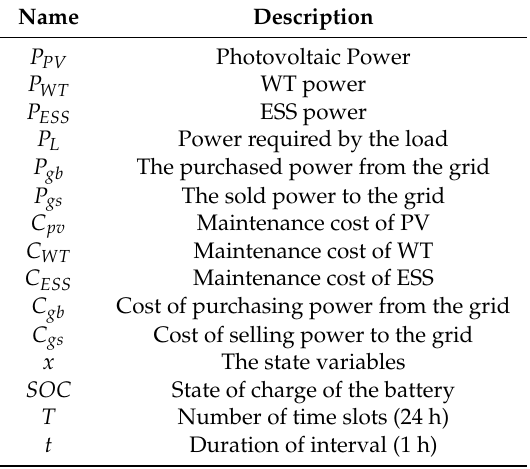
Table 1. Parameters and variables of the model. WT: wind turbine; ESS: energy storage systems; PV: